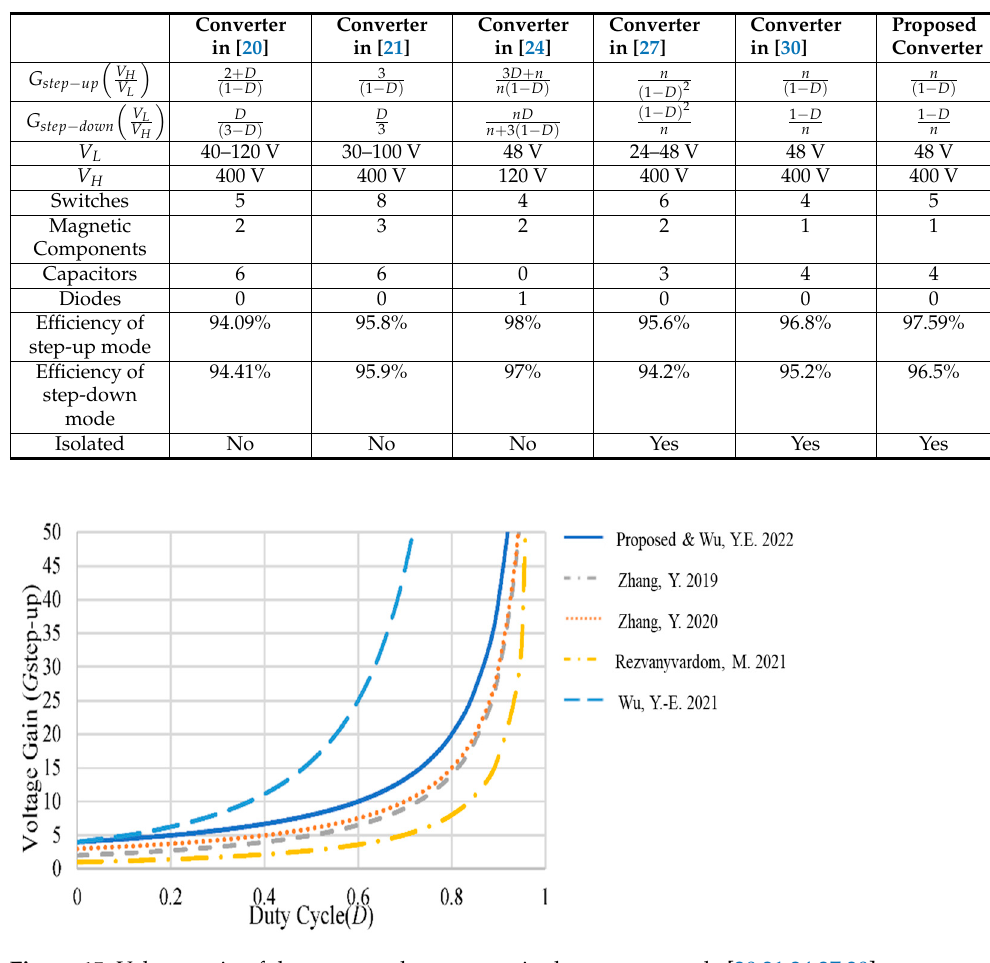
Table 2. Comparison between the proposed converter and related bidirectional converters.